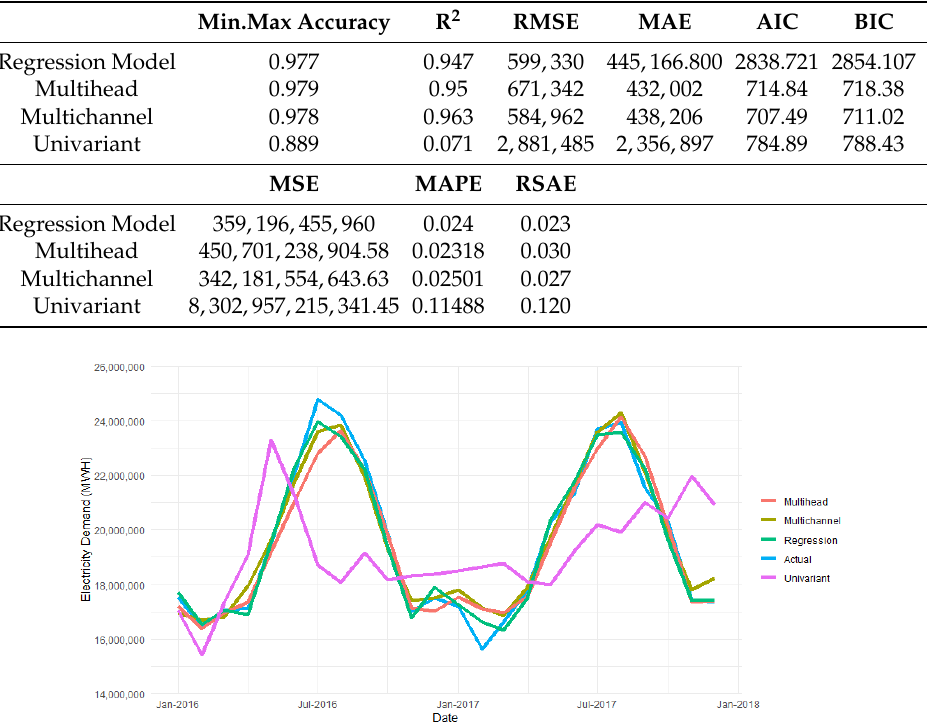
Table 5. Overall model results.